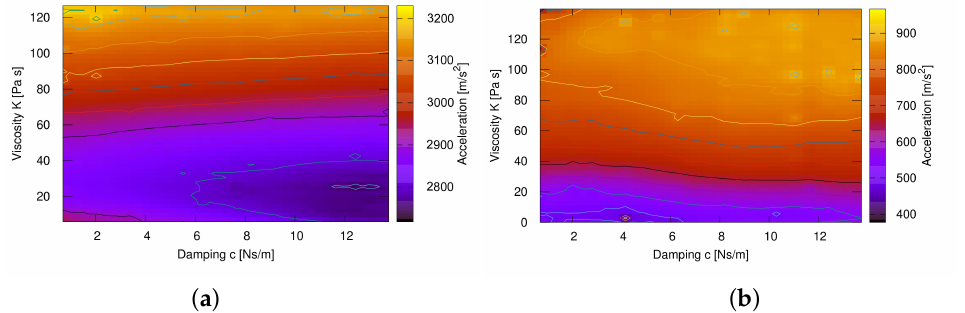
Figure 6. Optimum stiffness K and damping c for viscoplastic material with m = 0.5 ( a ) and softening with m = − 0.5 ( b ).